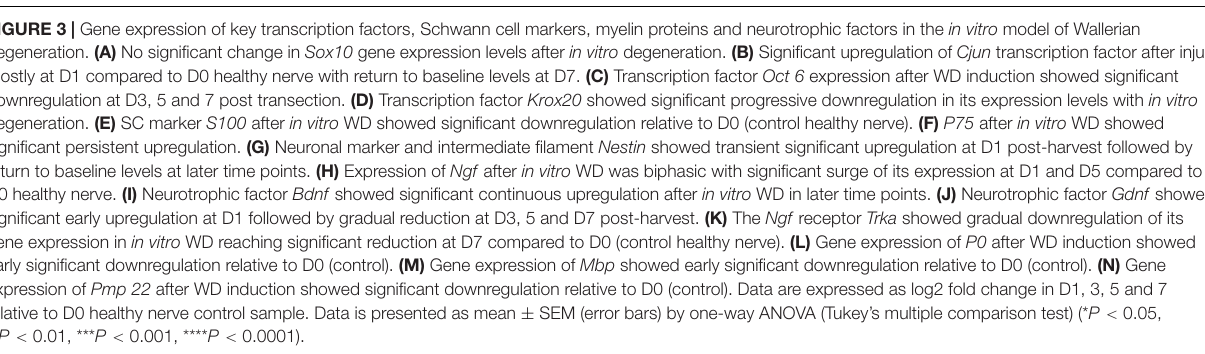
FIGURE 3 | Gene expression of key transcription factors, Schwann cell markers, myelin proteins and neurotrophic factors in the in vitro model of Wallerian degeneration. (A) No significant change in Sox10 gene expression levels after in vitro degeneration. (B) Significant upregulation of Cjun transcription factor after injury mostly at D1 compared to D0 healthy nerve with return to baseline levels at D7. (C) Transcription factor Oct 6 expression after WD induction showed significant downregulation at D3, 5 and 7 post transection. (D) Transcription factor Krox20 showed significant progressive downregulation in its expression levels with in vitro degeneration. (E) SC marker S100 after in vitro WD showed significant downregulation relative to D0 (control healthy nerve). (F) P75 after in vitro WD showed significant persistent upregulation. (G) Neuronal marker and intermediate filament Nestin showed transient significant upregulation at D1 post-harvest followed by return to baseline levels at later time points. (H) Expression of Ngf after in vitro WD was biphasic with significant surge of its expression at D1 and D5 compared to D0 healthy nerve. (I) Neurotrophic factor Bdnf showed significant continuous upregulation after in vitro WD in later time points. (J) Neurotrophic factor Gdnf showed significant early upregulation at D1 followed by gradual reduction at D3, 5 and D7 post-harvest. (K) The Ngf receptor Trka showed gradual downregulation of its gene expression in in vitro WD reaching significant reduction at D7 compared to D0 (control healthy nerve). (L) Gene expression of P0 after WD induction showed early significant downregulation relative to D0 (control). (M) Gene expression of Mbp showed early significant downregulation relative to D0 (control). (N) Gene expression of Pmp 22 after WD induction showed significant downregulation relative to D0 (control). Data are expressed as log2 fold change in D1, 3, 5 and 7 relative to D0 healthy nerve control sample. Data is presented as mean ± SEM (error bars) by one-way ANOVA (Tukey’s multiple comparison test) (* P < 0.05, ** P < 0.01, *** P < 0.001, **** P <